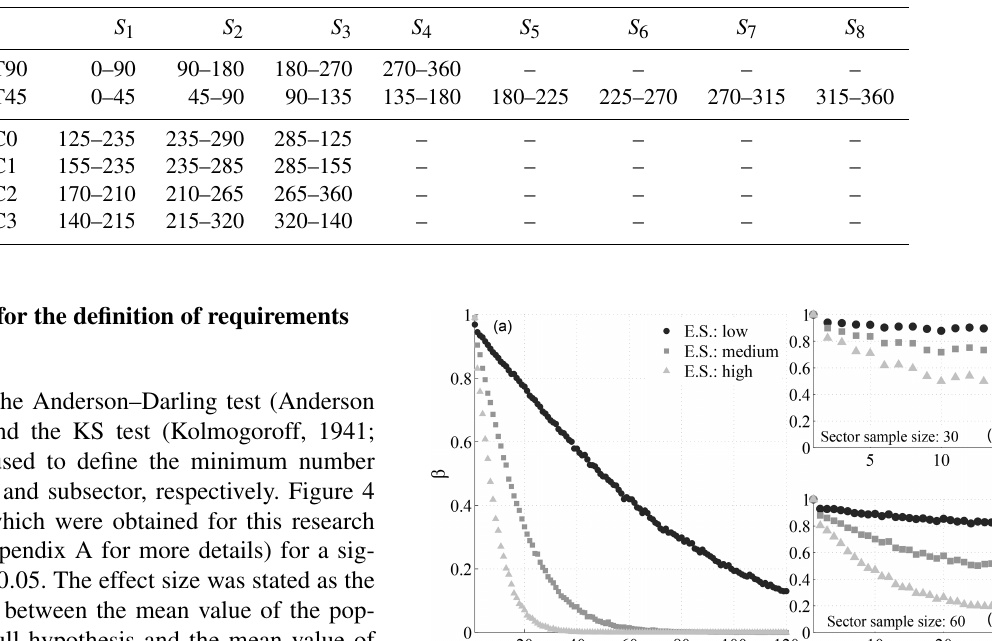
Table 1. Directional sectors resulting from applying the different selection criteria.